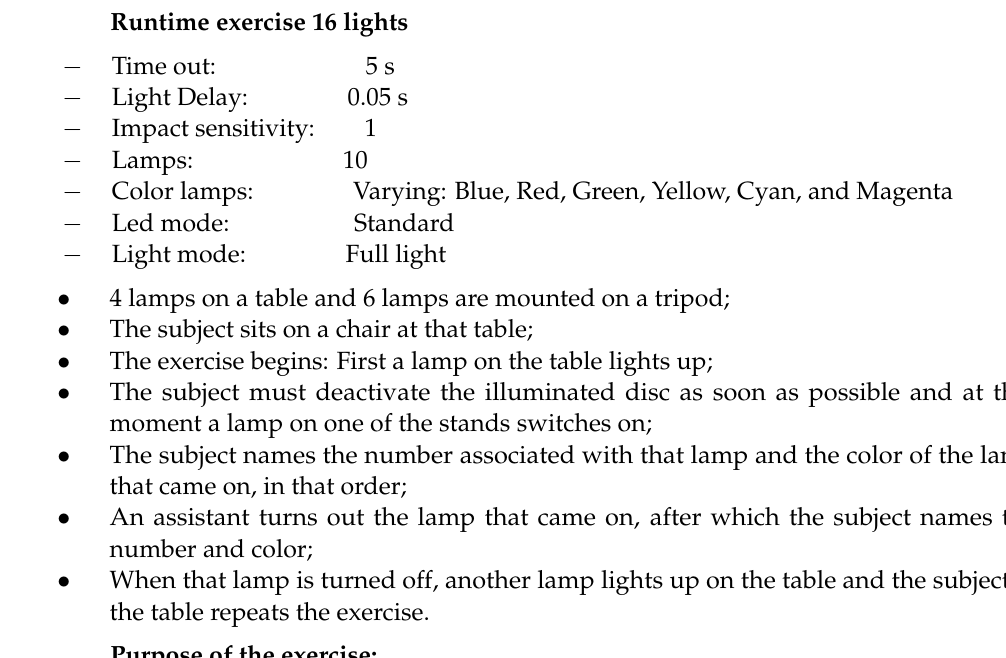
Figure A2. FitLight ® s for testing eyes’ fusion flexibility by the reaction time of saccades from looking at the lights on the table, and redirecting the eyes to the distant lights and numbers. The specification of this set-up is: The ability to diverge and converge with the eyes is trained with this set-up and